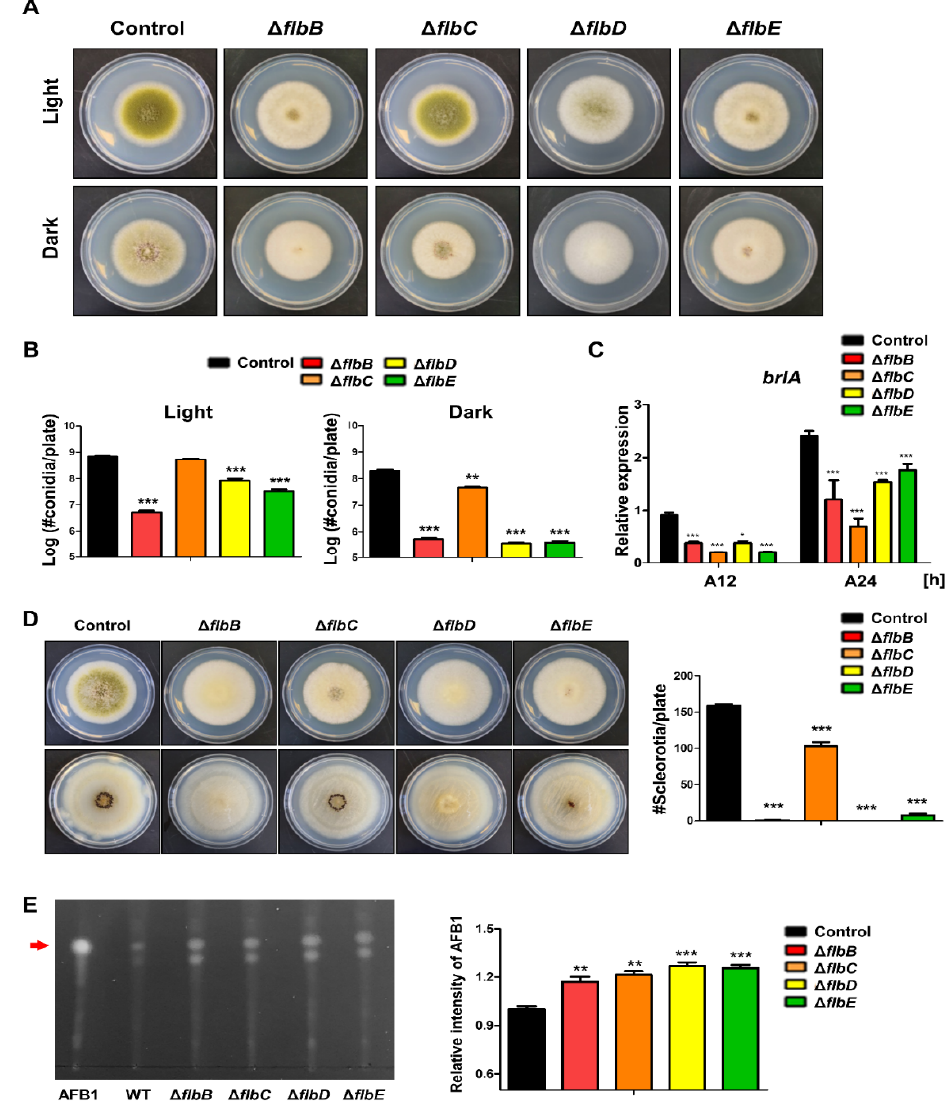
Figure 4. Roles of the fluffy genes in A. flavus. ( A ) Colony morphology of ∆ flbB , ∆ flbC , ∆ flbD , and ∆ flbE mutant strains. ( B ) Quantitative analysis of the number of conidia per plate shown in ( A ). ( C ) mRNA level of brlA in wild-type and mutant strains. ( D ) Ethanol-washed colony photographs of fluffy mutant strains. ( E ) Image of TLC of aflatoxin B1 from fluffy mutant strains. Densitometry of TLC analysis results. Statistical differences between control and mutant strains were evaluated using Student’s unpaired t -tests. Data are reported as the mean ± standard deviation. * p < 0.05, ** p < 0.01, and *** p <